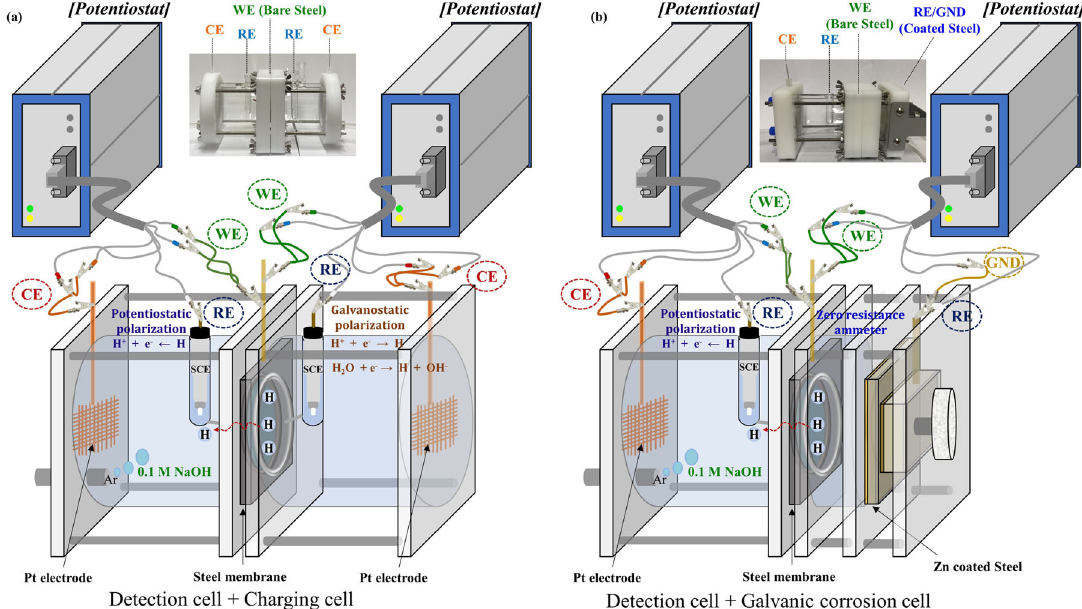
Fig. 15 Schematic diagram of the permeation apparatus. a Typical permeation apparatus (hydrogen charging cell + hydrogen detection cell). b Modi fi ed permeation apparatus (galvanic corrosion cell + hydrogen detection